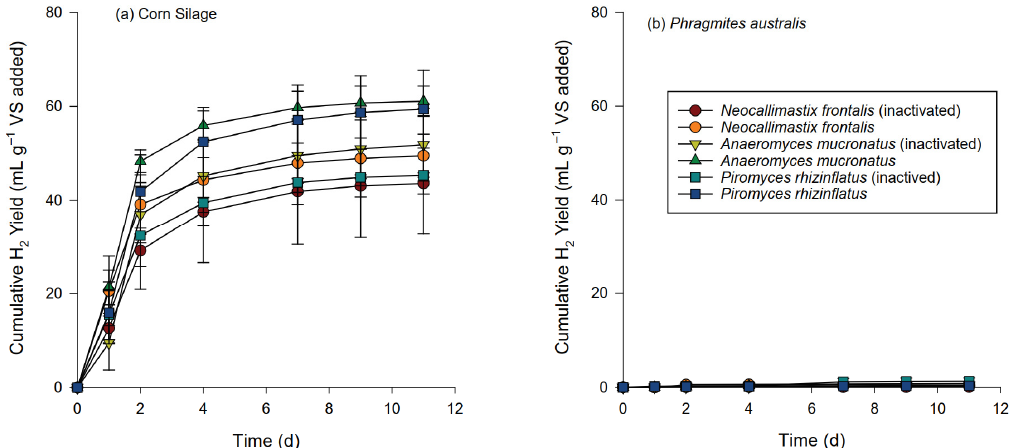
Figure 1. Cumulative hydrogen yield in the bioaugmentation of three different anaerobic fungal species: ( a ) corn silage ( Zea mays L.); ( b ) common reed ( Phragmites australis ). Error bars show standard deviation.